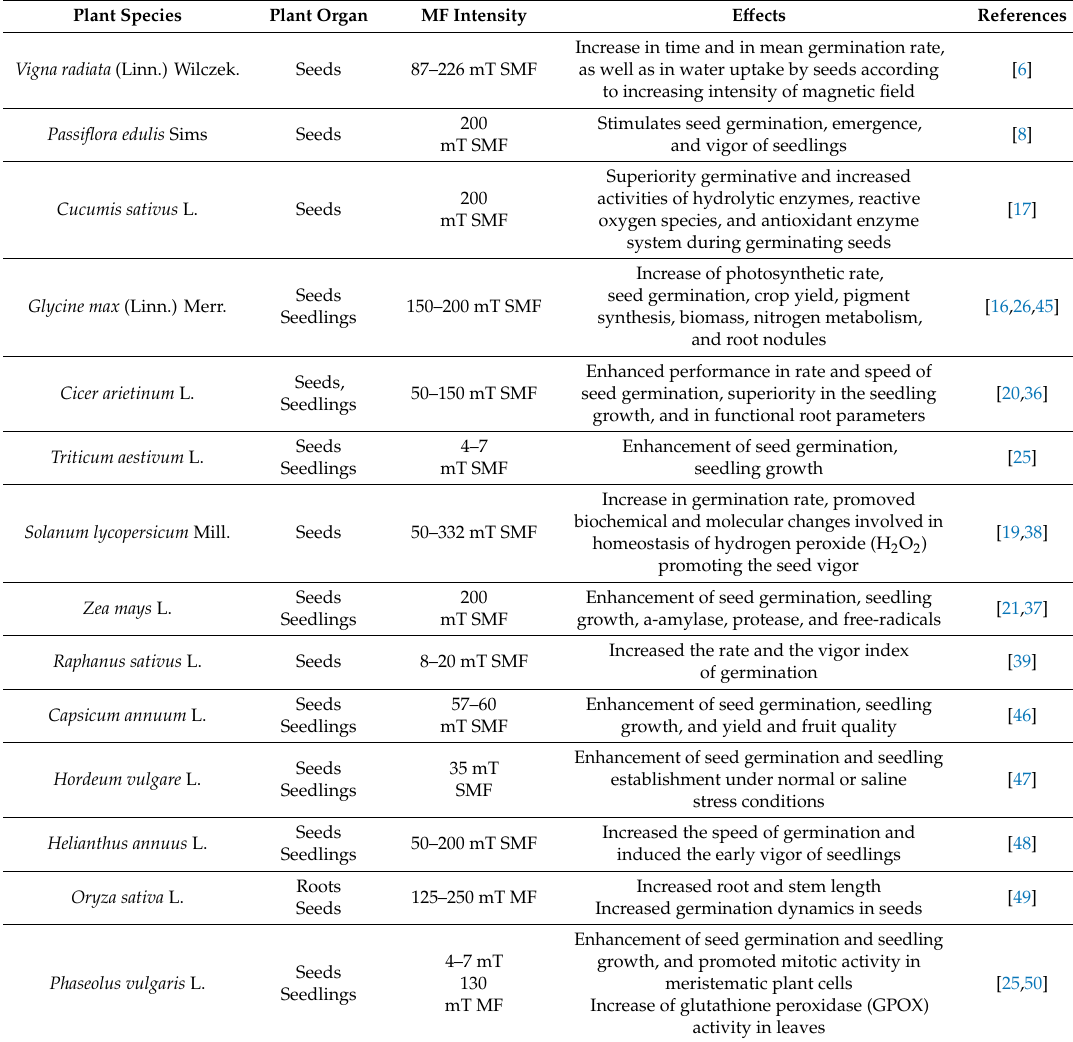
Table 1. Application of magnetic field in seed